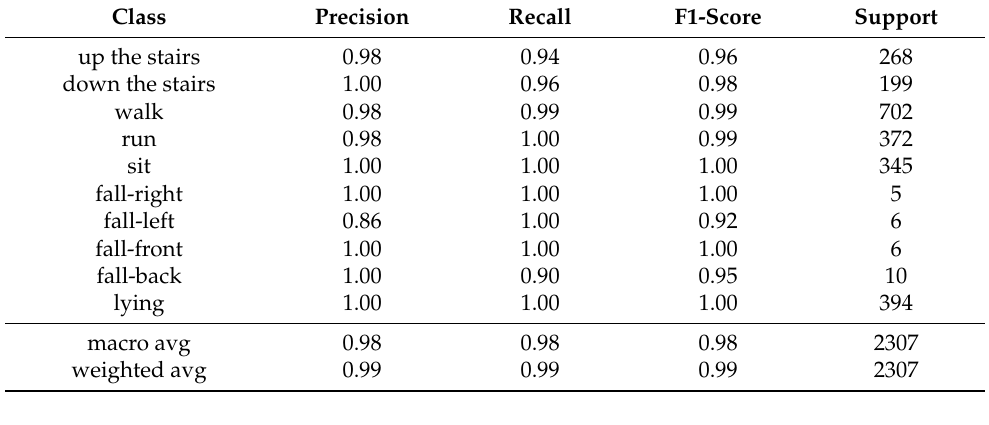
Table 4. Classification report using the ensemble learning-based approach.